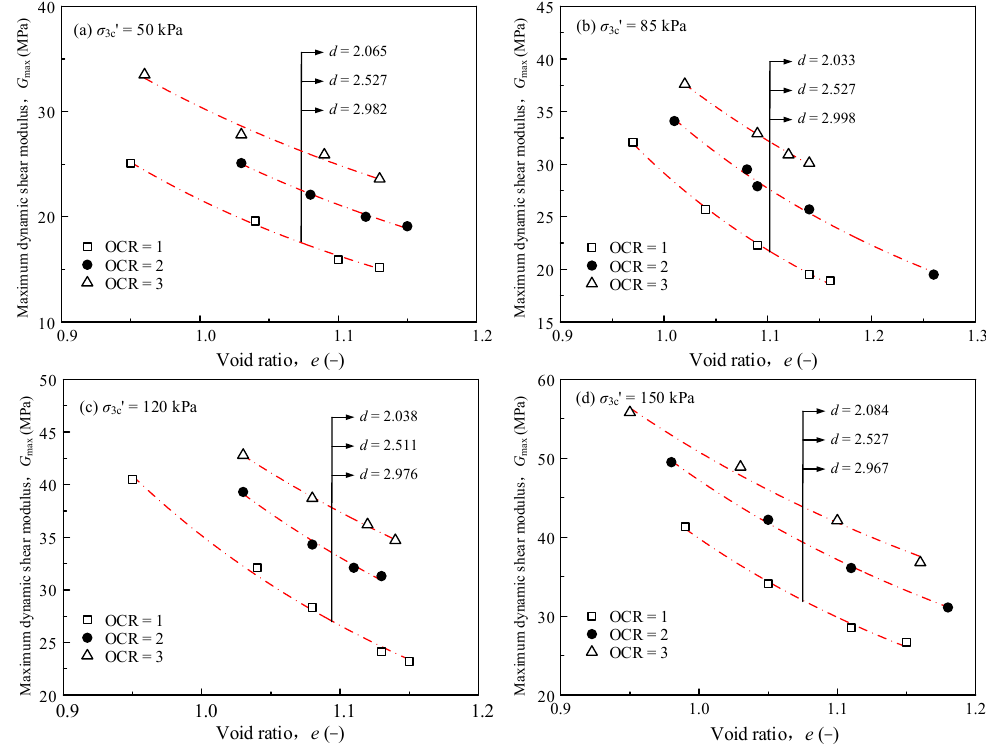
Figure 4. The relationship between G max and e under different σ 3c ’: ( a ) σ 3c ’ = 50 kPa, ( b ) σ 3c ’ = 85 kPa, ( c ) σ 3c ’ = 120 kPa, ( d ) σ 3c ’ = 150 kPa.